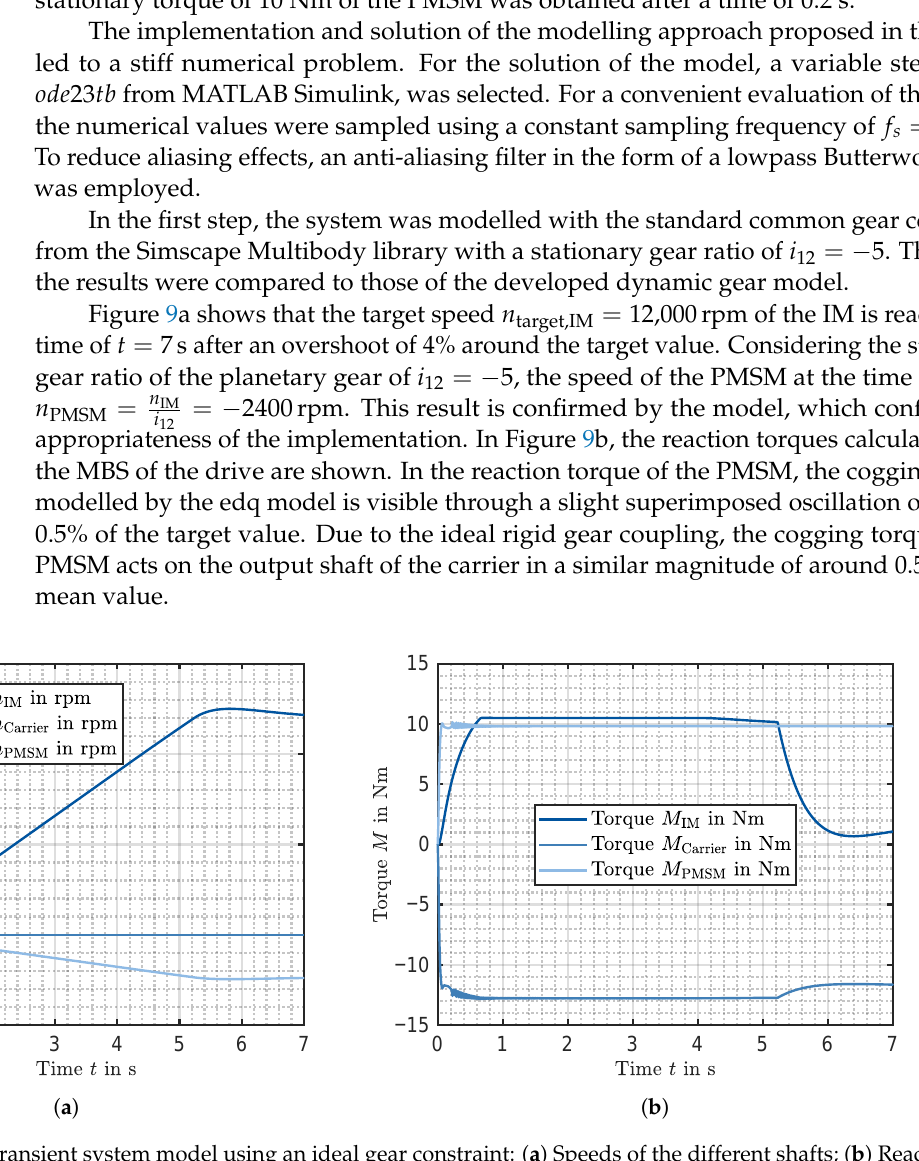
Figure 9. Results of the transient system model using an ideal gear constraint: ( a ) Speeds of the different shafts; ( b ) Reaction torques of the different